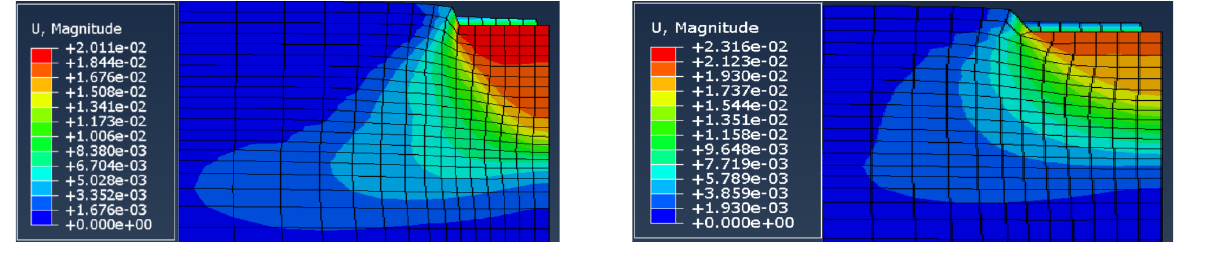
Figure 18 : Displacement contours of case 1 at h/B = 1.225 for L/B=1. Figure 19 : Displacement contours of case 8 at h/B = 1.225 for L/B=1.